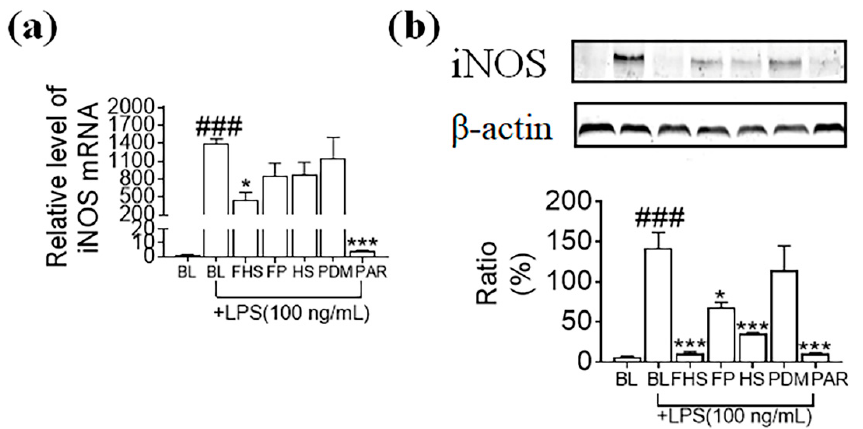
Figure 2. Effects of FHS, FP, HS, and PDM on iNOS at mRNA and protein expression levels. ( a ) mRNA expression of iNOS was amplified by Real-Time PCR ( n = 3). Cells were incubated with FHS, FP, HS, and PDM for 1 h and then were incubated with LPS for another 4 h. ( b ) The protein expres- sion of iNOS was quantified by western blot ( n = 3). Cells were incubated with FHS, FP, HS, and PDM for 1 h, and then incubated with LPS for another 24 h. The protein expression was standard- ized with β -actin. BL, medium without the addition of extracts; FHS, fermented hemp seed-contain- ing medium’s supernatant of Day 7; FP, fermented regular PDB medium’s supernatant of Day 7; HS, unfermented hemp seed-containing medium’s supernatant; PDM, unfermented regular PDB medium’s supernatant. ### p < 0.001 vs the control group; * p < 0.05, *** p < 0.001 vs the LPS-treated group.